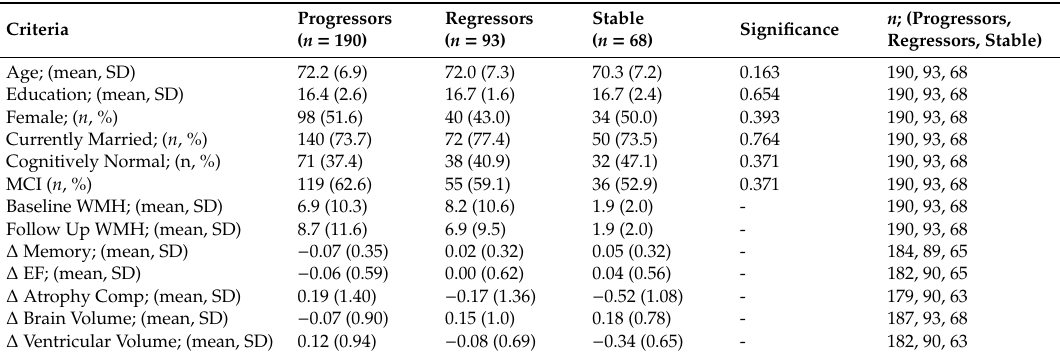
Table 2. Demographic, clinical, imaging, and change scores for subjects demonstrating progression, stability, and regression in white matter hyperintensity volumes. WMH is reported in cubic centimeters; Memory and executive function (EF) are reported in standardized scores, and Atrophy composite, brain volume, and ventricular volume are z-scored. Raw scores for brain and ventricular volume per group can be viewed in Table